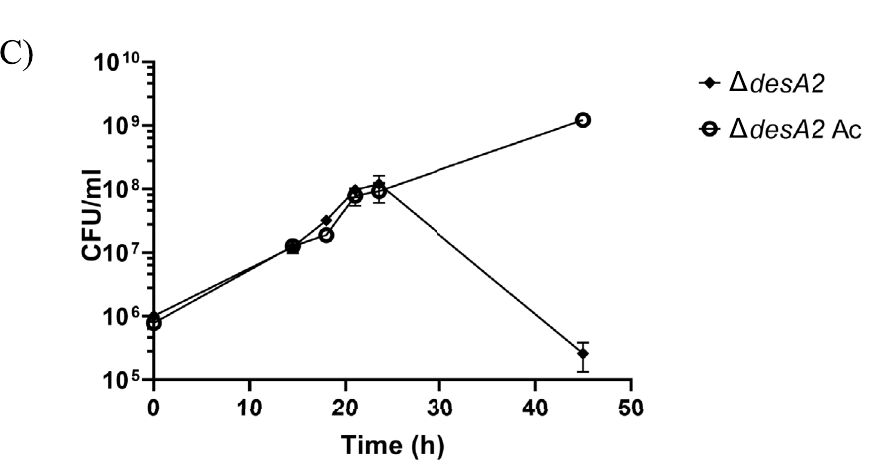
Figure 3. Growth of the ∆ desA2 mutant and the parental merodiploid strain on TSB agar plate ( A ) and 7H9 broth ( B ) in the presence or absence of acetamide. Serial dilutions spotted onto the TSB agar plates are indicated as a guide in the plate on the left ( C ) Growth curve of the ∆ desA2 mutant in 7H9 broth with or without